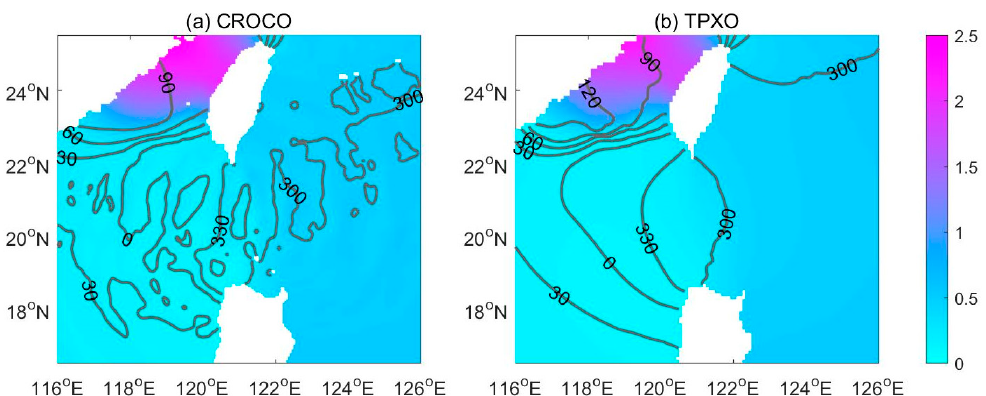
Figure 2. The M 2 surface elevations amplitudes (shading, unit: m) and phases (grey lines, unit: degrees) extracted from ( a ) the Full case simulation and ( b ) the TPXO7.2 tidal model.